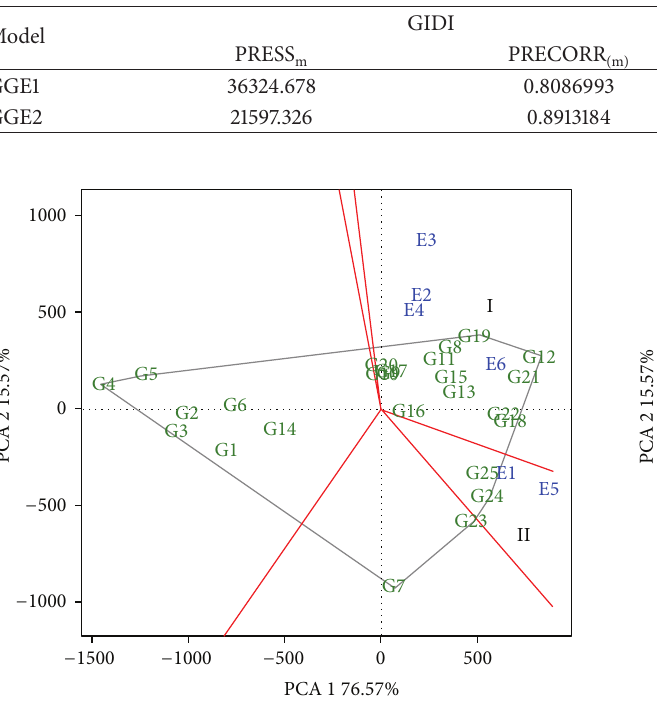
Figure 2: GGE biplot graph, with the distance of the 25 hybrids (identified from G1 to G25) from the “ideal genotype” in regard to the GIDI. Concentric circles facilitate the exploratory analysis of the distances between the genotypes evaluated and the ideal genotype represented by the green